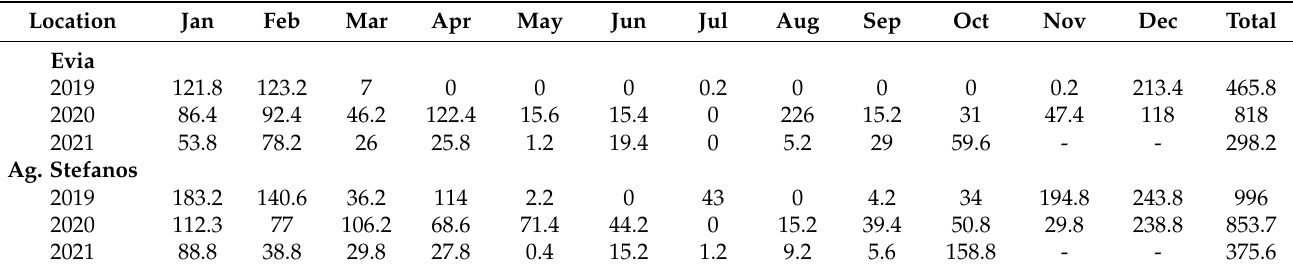
Table 1. Monthly precipitation (mm) as recorded by the meteorological stations near the examined sites. Loca- tion